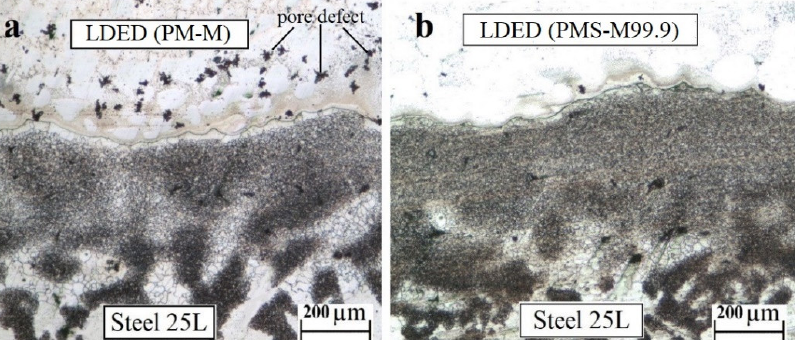
Figure 9. Microstructure of the Mo-steel boundary after LDED (×100): ( a ) powder PM-M; ( b ) powder PMS-M99.9.